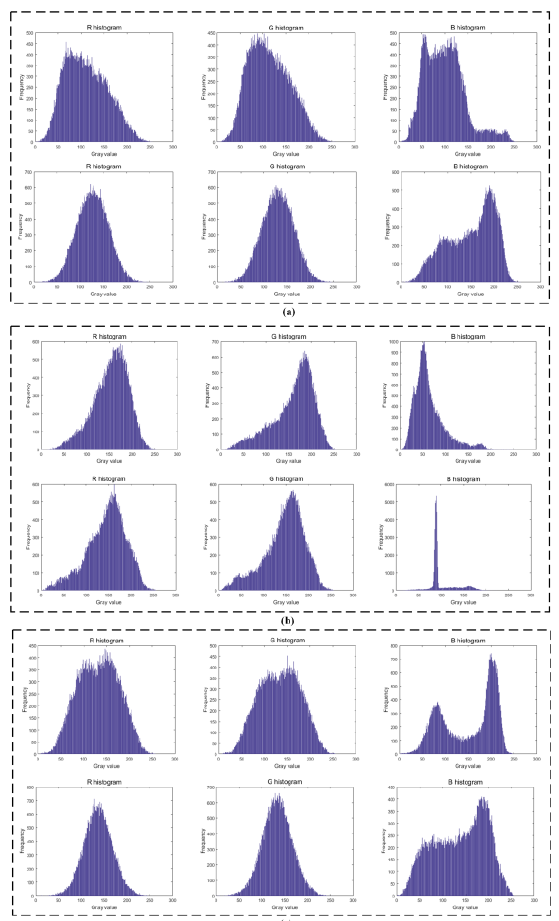
Figure 1. The spectral distribution difference between NWPU- RESISC45 and UC Merced dataset in some specific classes. (a) Airplane. (b) River and (c) Chaparral.